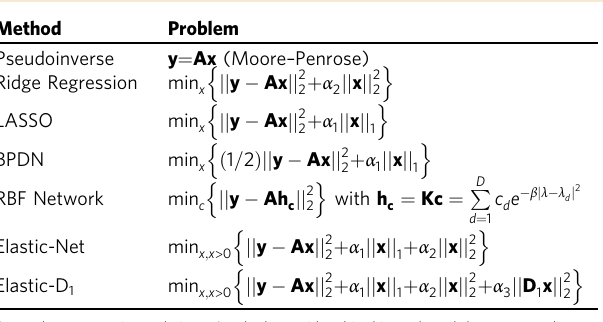
Table 1 Reconstruction methods